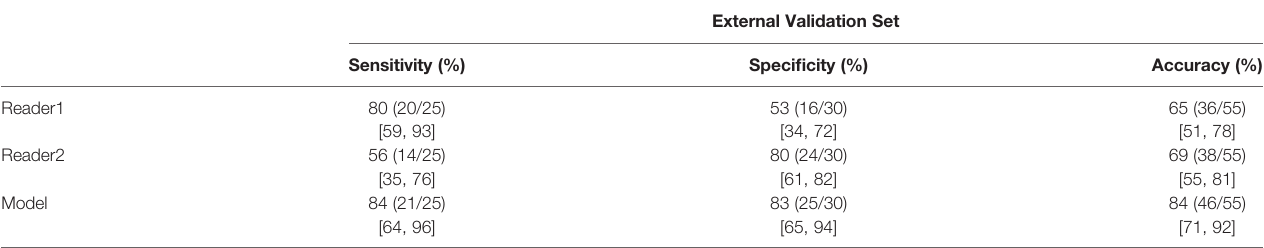
TABLE 3 | Sensitivity, Speci fi city, and Accuracy for Differentiating Lipid-Poor Adenomas from Nonadenomas by Two Readers and the